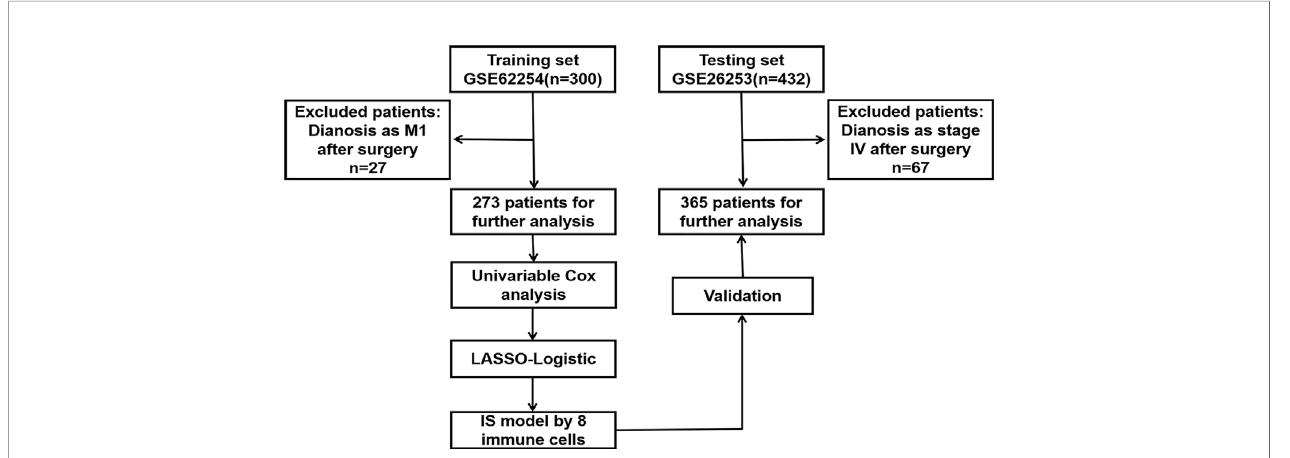
FIGURE 1 | The fl owchart through the identi fi cation procedure and analyses. LASSO least absolute shrinkage and selection